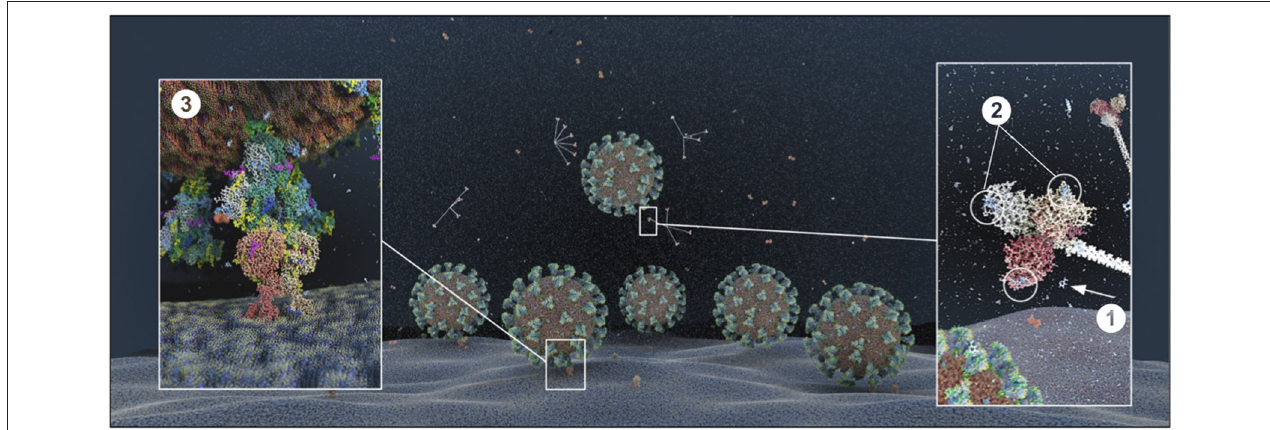
FIGURE 19 | Atomistic reconstruction of SARS-CoV-2 virions in ASL with high glucose concentration (1.2mM). In patients with high glucose in the ASL, the concentration of antibacterial agents (lactoferrin, β -defensin) is decreased. Glucose molecules (1) in excess bind to the CRD domain of the SP-D heads, [(2) two glucose molecules may bind each head of the trimer], competing for virus recognition. More virions reach the surface of the epithelial cells to bind their receptor ACE2 (3) for further endocytosis (see section Methods for detailed ID of the components presented). As the number and migration capacity of alveolar macrophages are decreased in high glucose, we did not include the macrophage in the